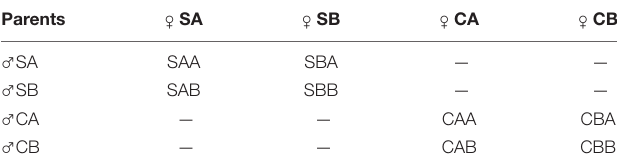
TABLE 2 | Mating strategy of P.